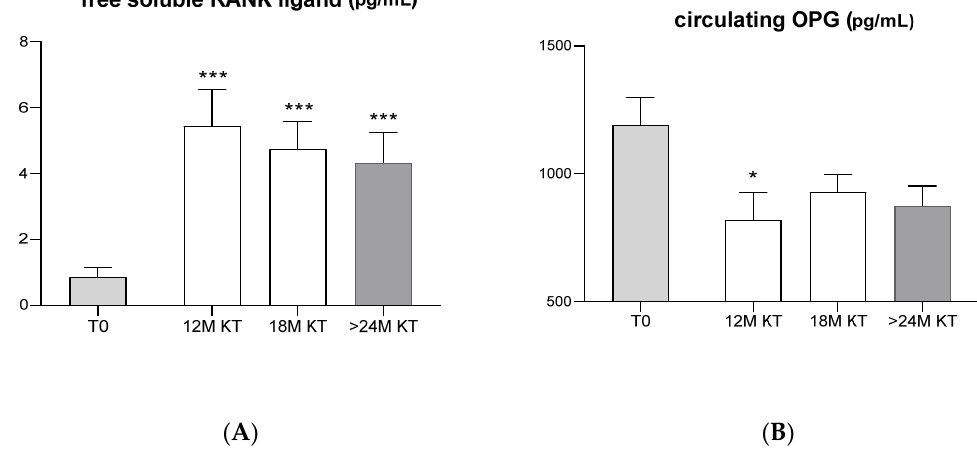
Figure 2. Circulating levels of free soluble RANK ligand ( A ) and osteo-protegerin ( B ) at baseline (T0 before KT n = 13) and 12 ( n = 6), 18 ( n = 10) and 24 months ( n = 6) after kidney transplantation. * p < 0.05 and *** p < 0.001, each time after TX (12, 18 and 24M) versus baseline (T0). By contrast, the OPG circulating levels were significantly reduced at 12 months after KT (1192 ± 105.4 pg/mL at baseline vs. 819.2 ± 109.0 pg/mL, p = 0.04), being lower than baseline levels until the moment of the second biopsy (Figure 2B).